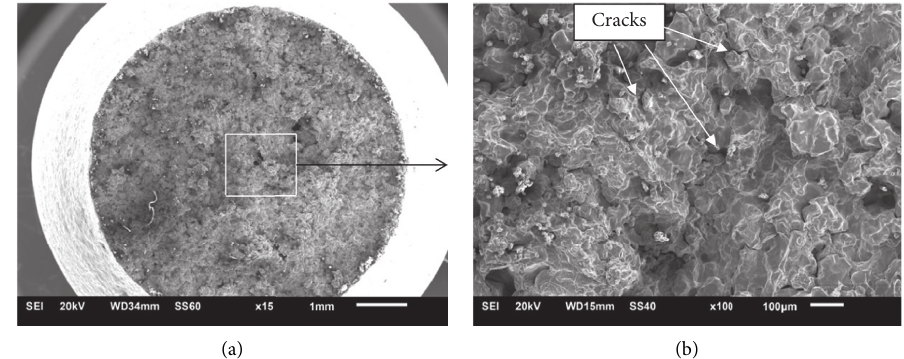
Figure 8: SEM fracture morphology in the central region of a tensile specimen deformed at 1373K and 0.1s − 1 . (a) General view. (b) Highlighted area of the white